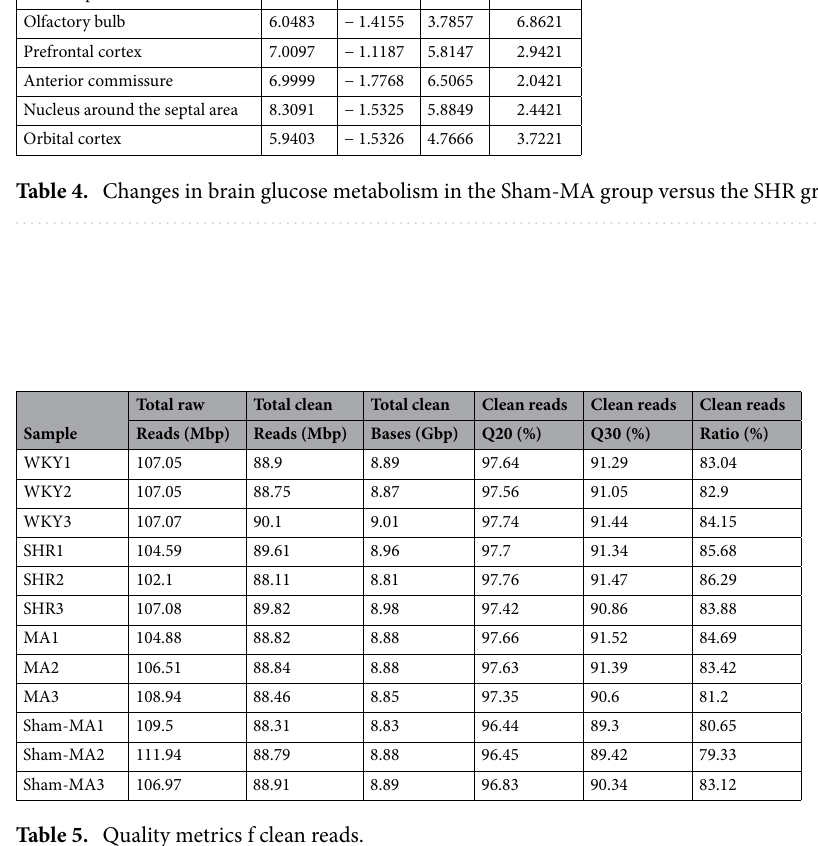
Table 5. Quality metrics f clean